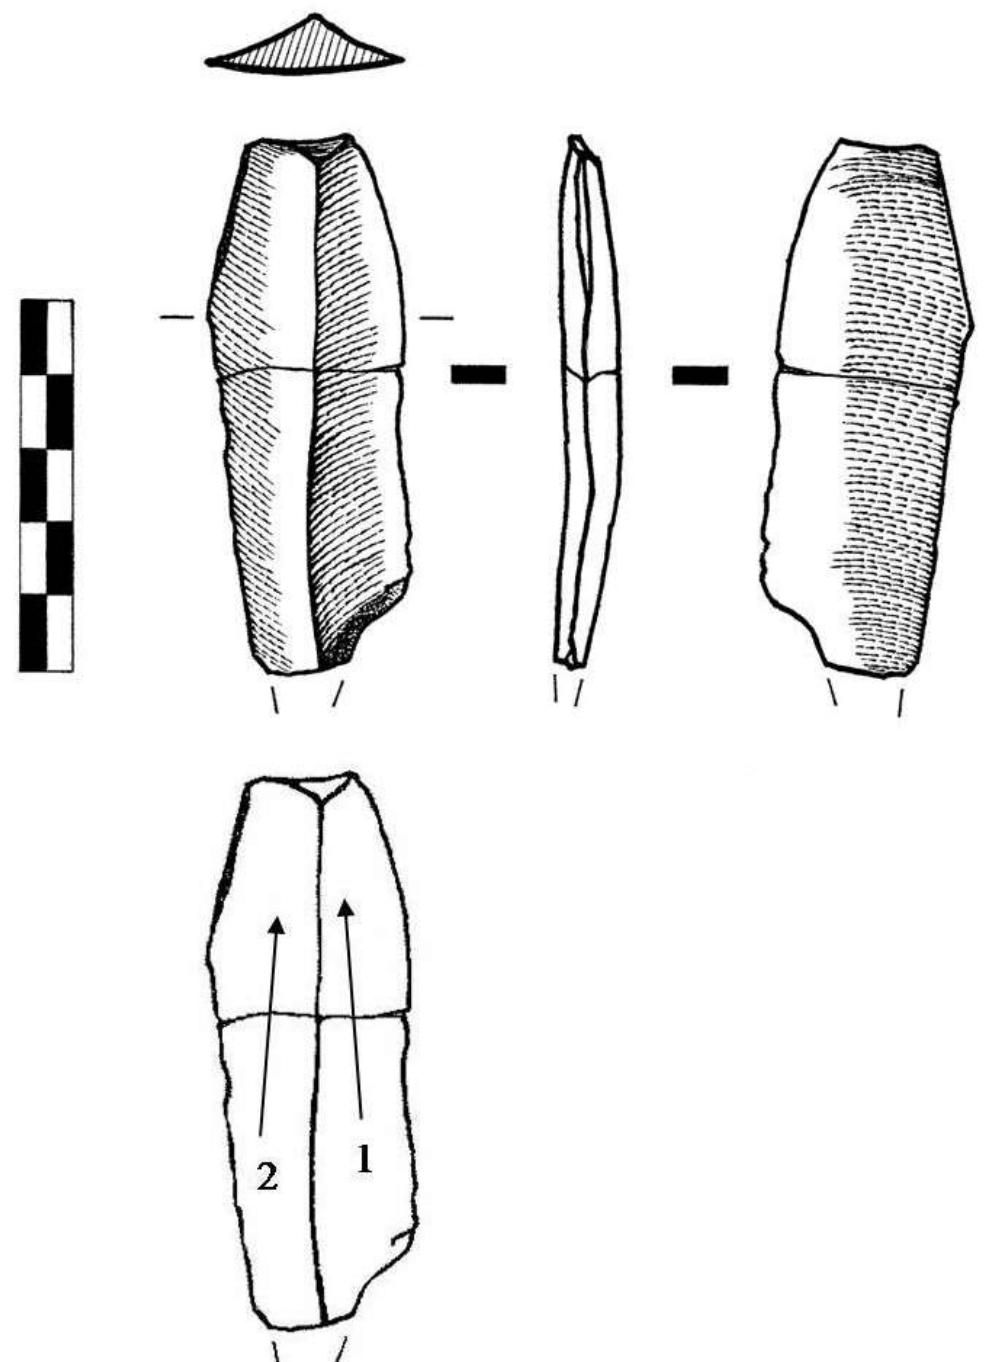
Figure 7. Technological drawing (superior) and diacritic scheme (inferior) of blade resulting from refitting fragments PCO026-a (bottom fragment) and PCO026-b (top fragment). Arrows indicate interpreted direction of the flaking and numbers indicate the order of